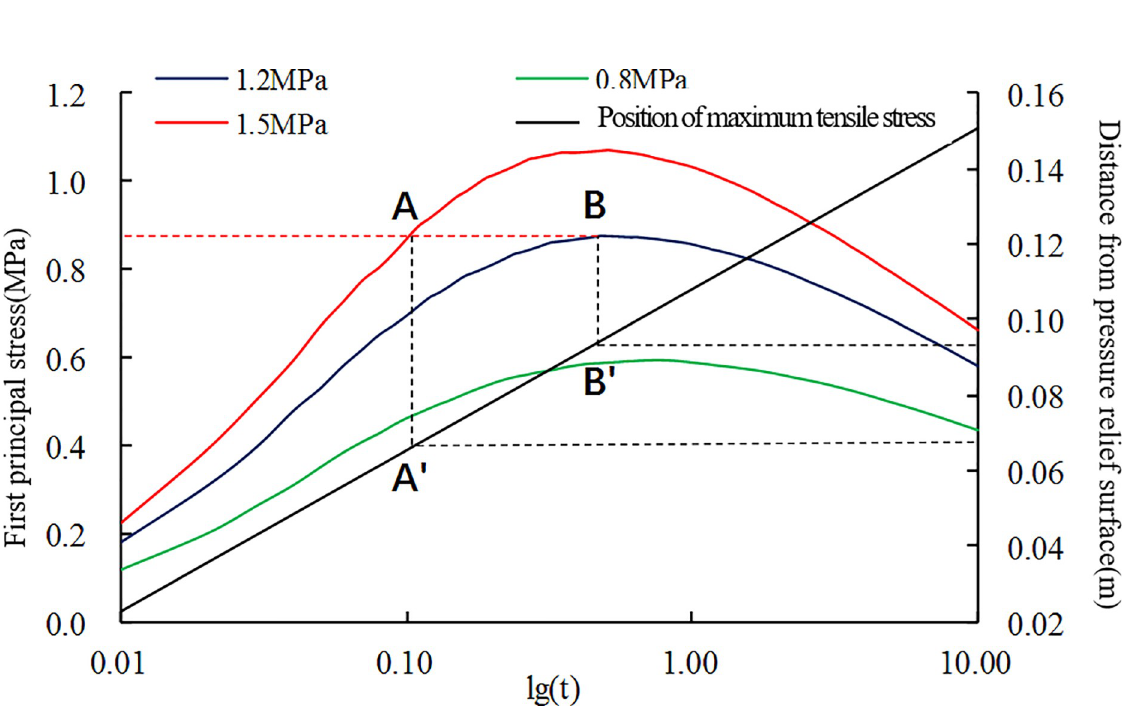
Fig 11. Maximum tensile stress and its location with time under different adsorption pressures.